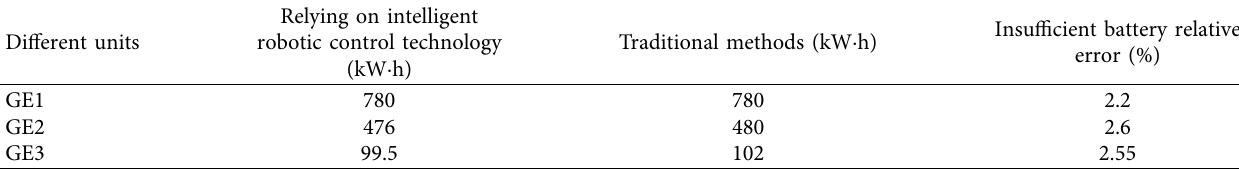
Table 1: Efects of diferent methods on power generation.